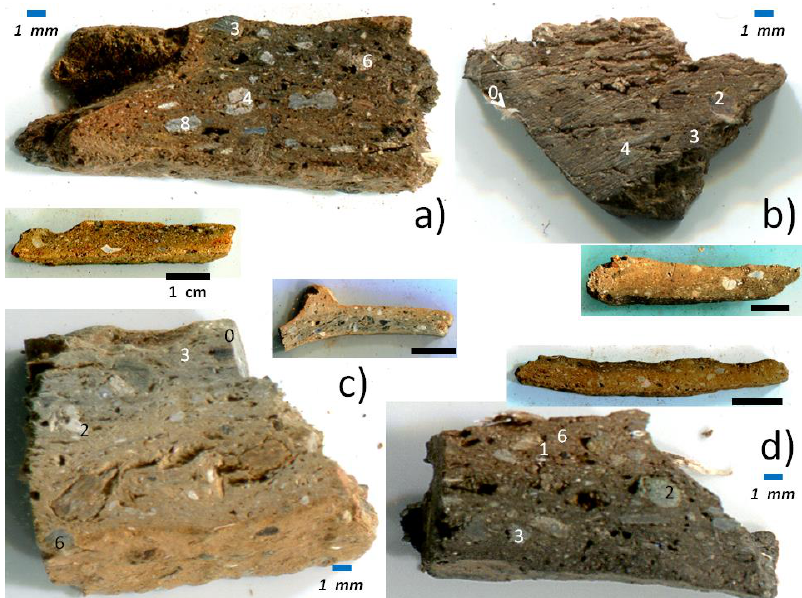
Figure 1. Cross sections of the 4 shards analyzed ( a – d , see Table 1). Raman analyzed spots are labeled.